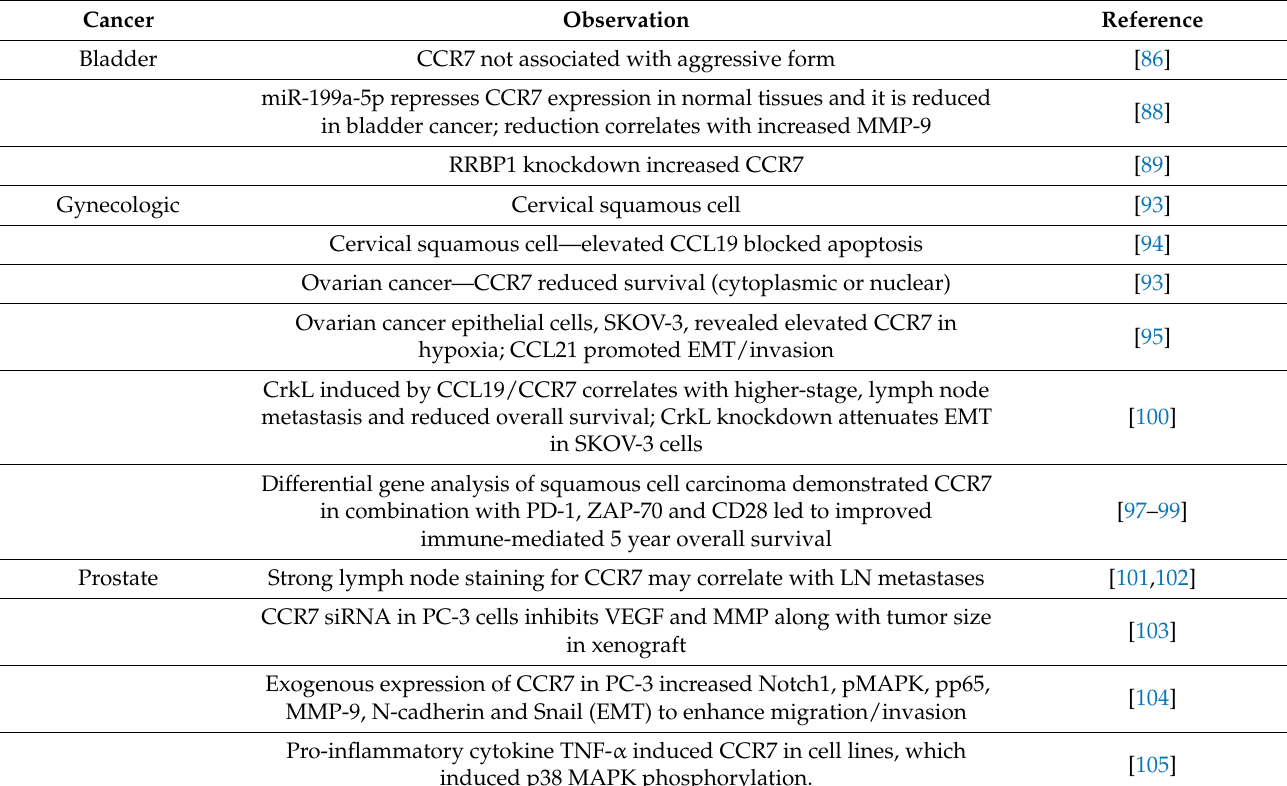
Table 2. The roles of CCR7 in genitourinary